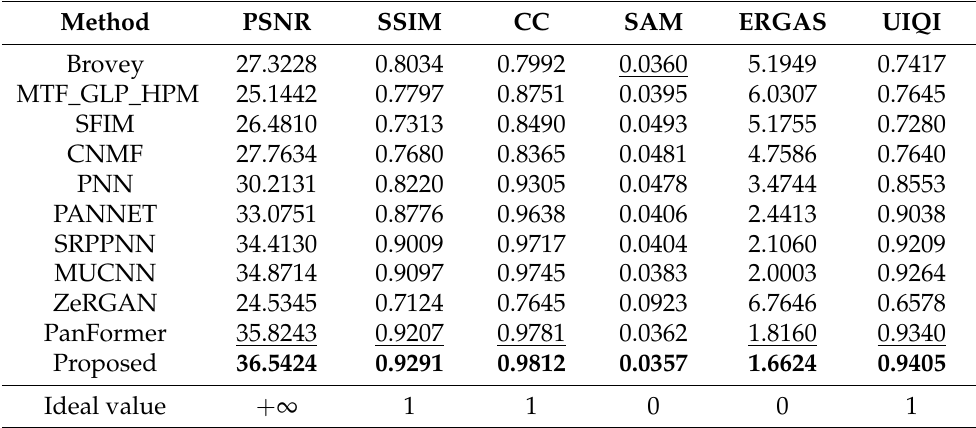
Table 1. Quantitative results of compared methods on the QB dataset in reduced resolution. The best values are shown in bold, and those in second place are